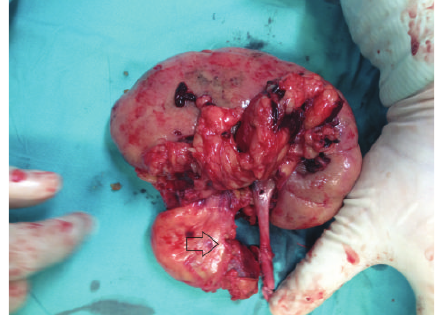
Figure 1: An intraparenchymal renal artery aneurysm.